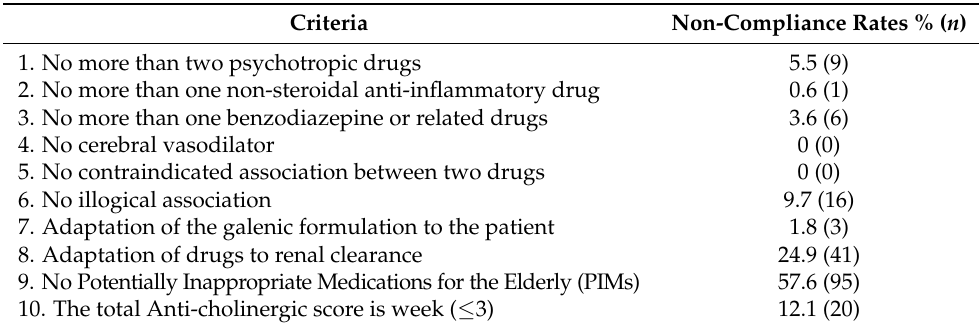
Table 2. Non-compliance rates after completion of the first phase.